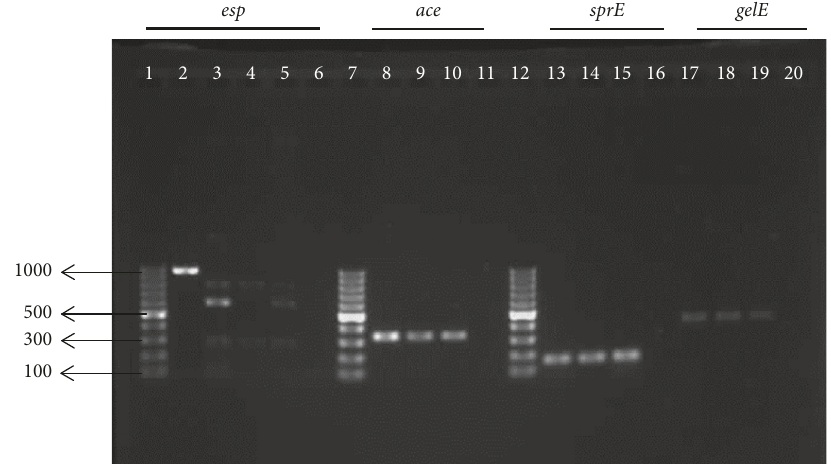
Figure 1: PCR screening for the presence of virulence genes in E. lactis PMD 74. Lanes 4, 8, 13, and 17: amplification products of corresponding genes obtained for OG1RF. Lanes 5, 9, 14, and 18: amplification products of corresponding genes obtained for E. faecalis ATCC 29212. Lanes 3, 10, 15, and 19: amplification products of corresponding genes obtained for E. lactis PMD 74. Lanes 1, 7, and 12: DNA ladder (100bp, Fermentas).